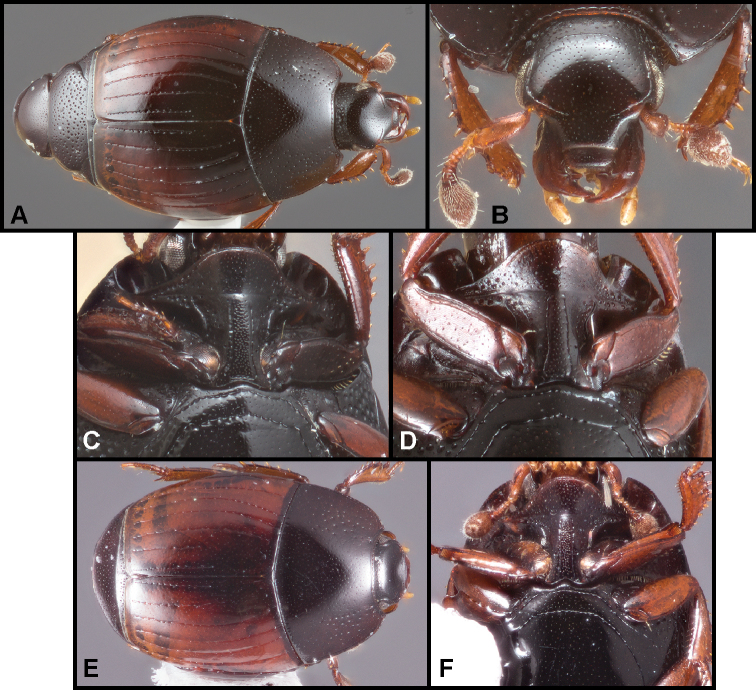
A–DPhelistersubrotundus (Say): A Dorsal habitus B Frontal view showing frontal striae C Prosternum and mesoventrite of male D Prosternum and mesoventrite of female E–FPhelisterrouzeti (Fairmaire) E Dorsal habitus F Ventral view of prosternum of male and meso- and metaventrites showing striae.